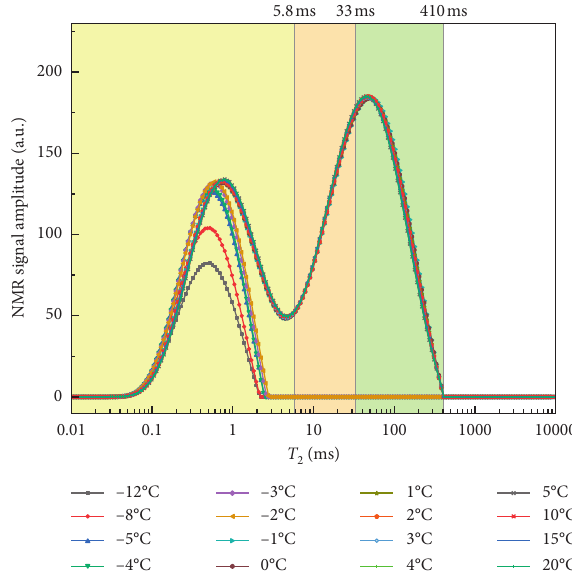
Figure 7: T 2 spectra during